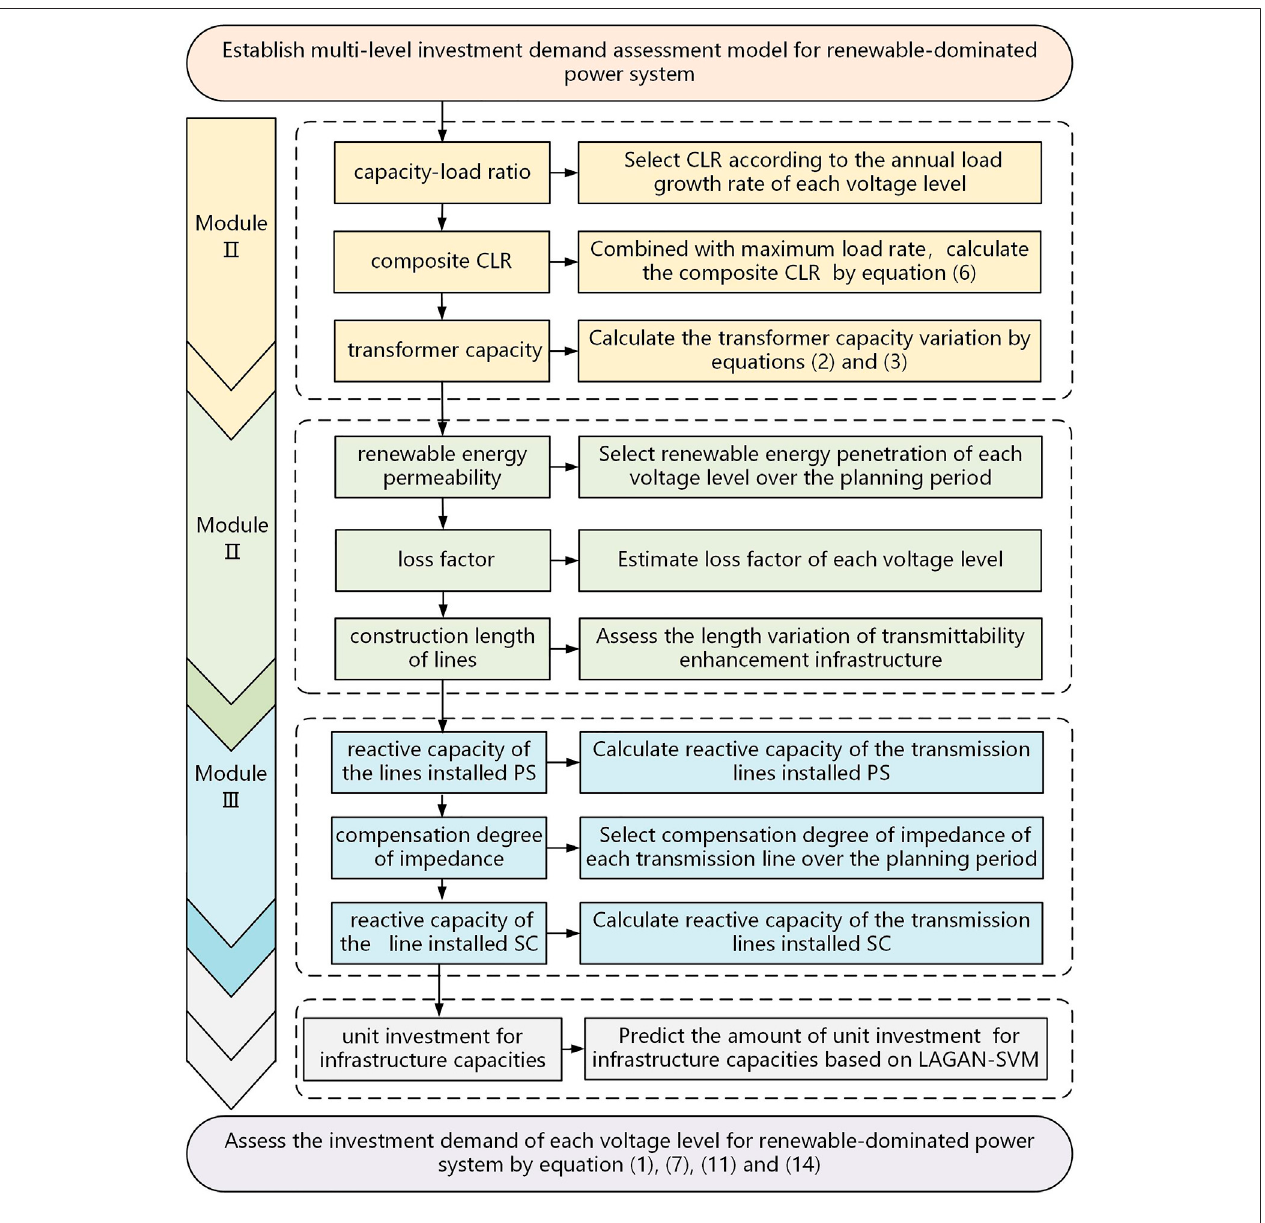
FIGURE 2 | Multi-level investment demand assessment model process for power